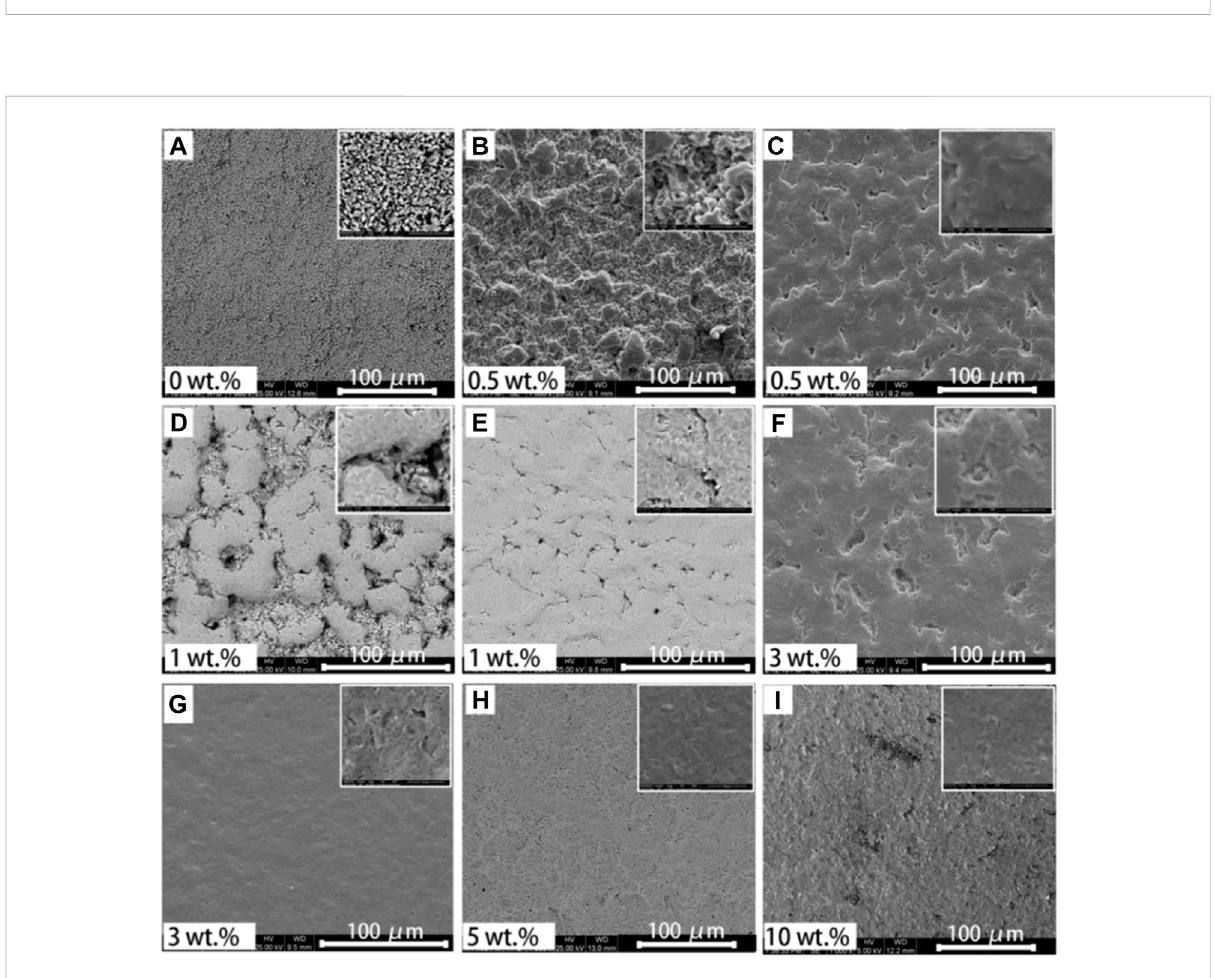
FIGURE 17 SEM morphologies of material surfaces after CE for 10 h in (A) pure water (B,C) 0.5 wt% (D,E) 1 wt% (F,G) 3 wt%, (H) 5 wt% and (I) 10 wt% sand suspensions, where b, d and f are obtained in the ring-like region, and c, e and g are from the center regions. The inserted images are local magni fi cation for the representative morphologies (Hu and Zheng,